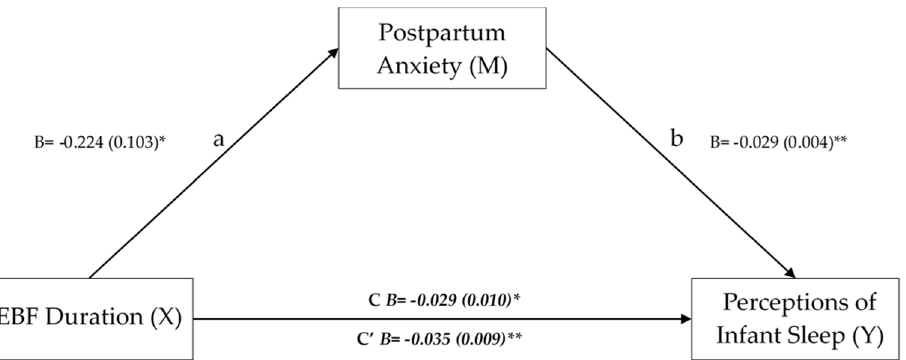
Figure 1. A simple mediation showing the total (C), direct (C’), and indirect effects of exclusive breastfeeding (EBF) duration on perceptions of infant sleep via postpartum anxiety after controlling for maternal age, socioeconomic status, birth order, and marital status. * = p < 0.05; ** p < 0.001.